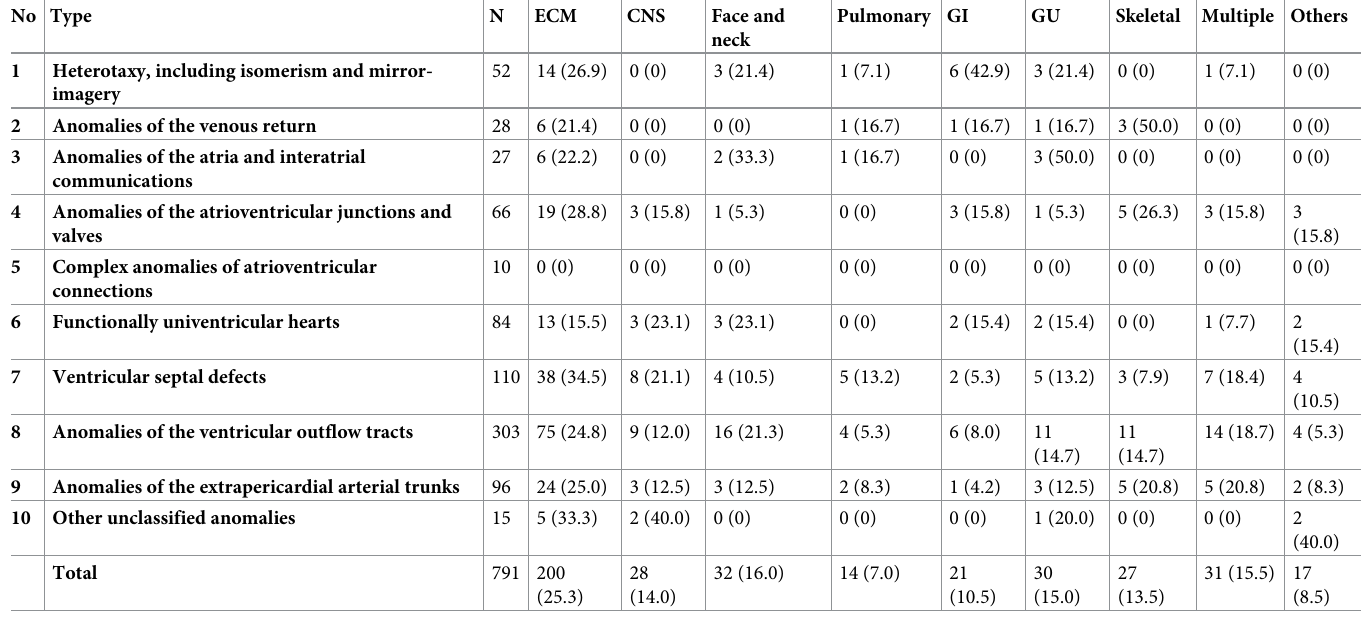
Table 4. Types of extracardiac malformation by type of congenital heart disease (total study